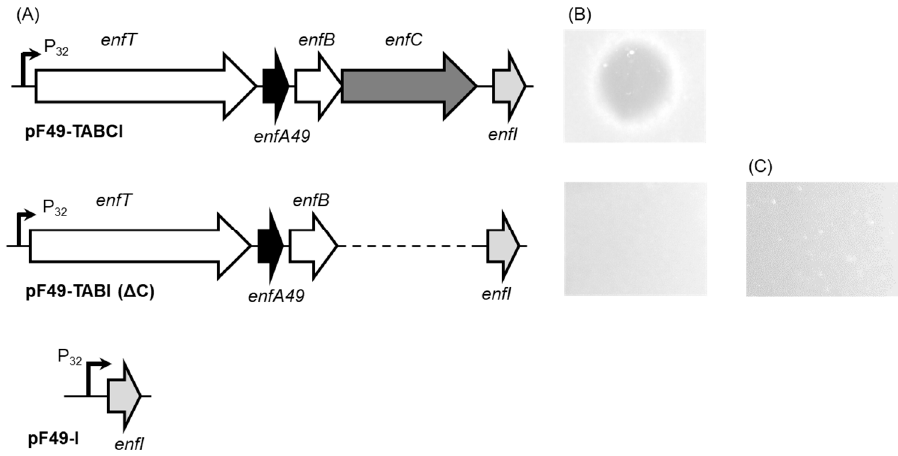
Figure 1. Plasmids construction for functional characterization of the enterocin F4-9 gene cluster and antibacterial activity of the resulting transformants. ( A ) Schematic illustrations of plasmids constructed in this study. Constructed plasmids were cloned and introduced into E . faecalis JH2-2, a host strain. ( B ) Evaluation of production of enterocin F4-9. Culture supernatants of transformants harboring pF49-TABCI and pF49-TABI were evaluated by the spot-on-lawn assay using E . faecalis JCM 5803 T as an indicator strain. ( C ) Evaluation of the intracellular fraction of the transformant harboring pF49-TABI by the spot-on-lawn assay using E. faecalis JCM 5803 T as an indicator strain.